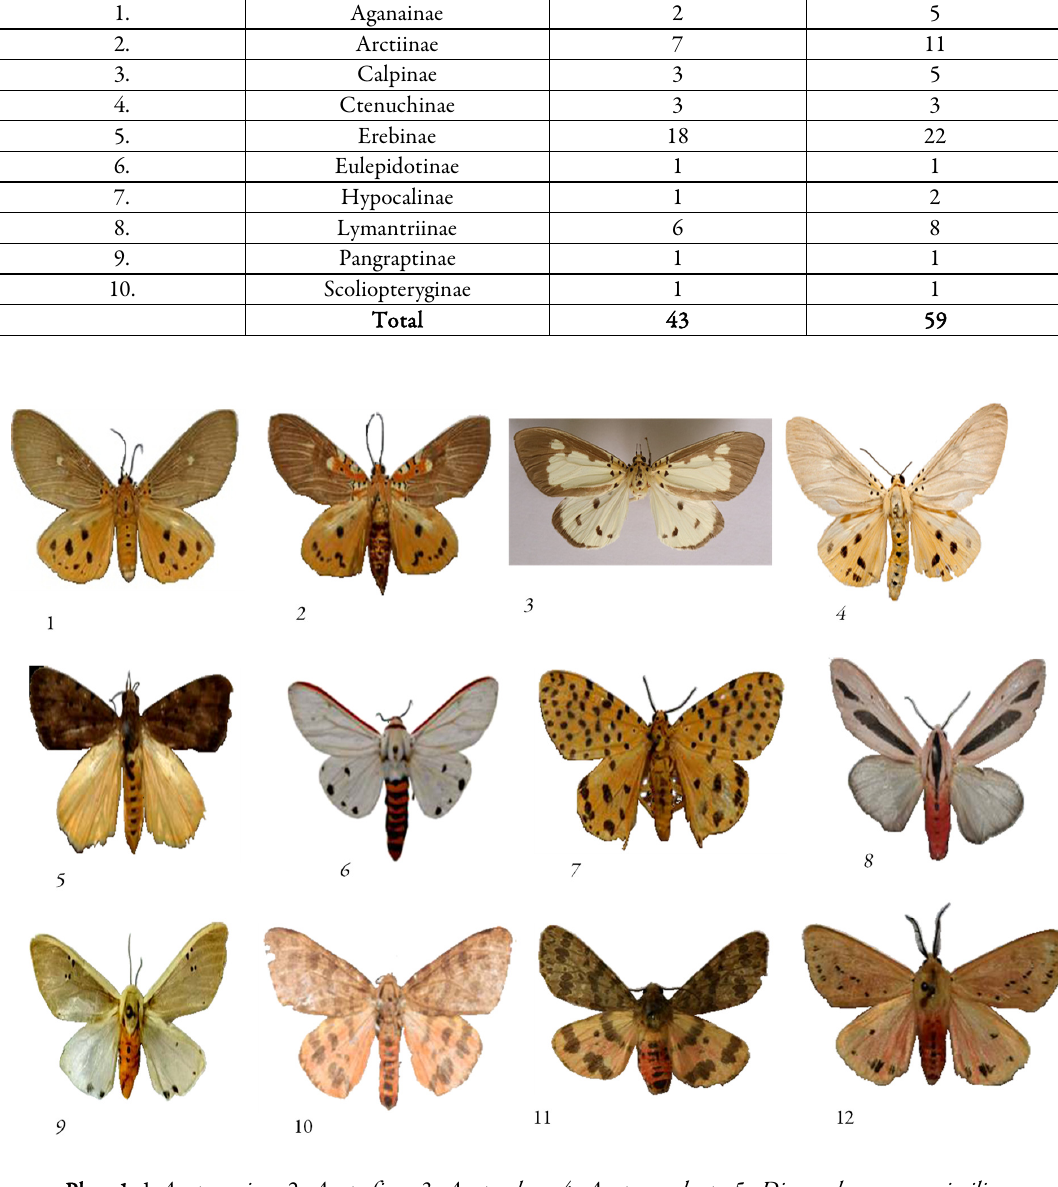
Table 3. Subfamily level breakdown for number of genus and species recorded during the survey S.